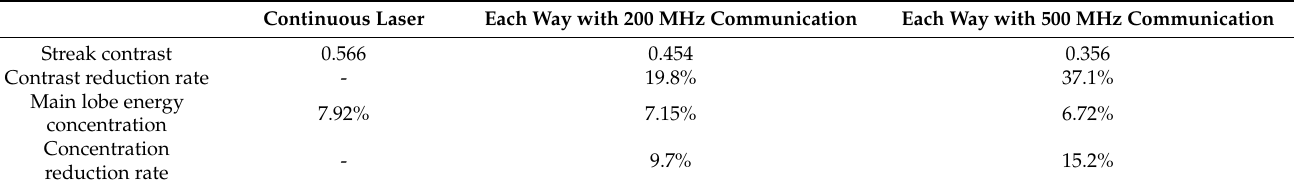
Table 2. The beam quality of interference fringes.